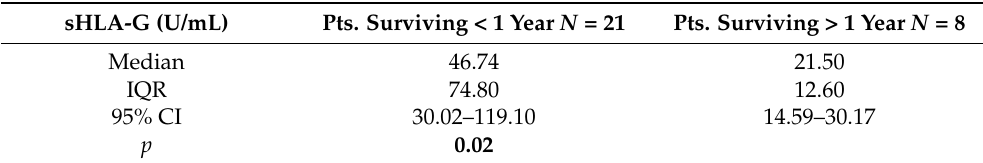
Table 9. Comparison of sHLA-G in patients with G. IV who survived more than one year and less than one year (nonparametric